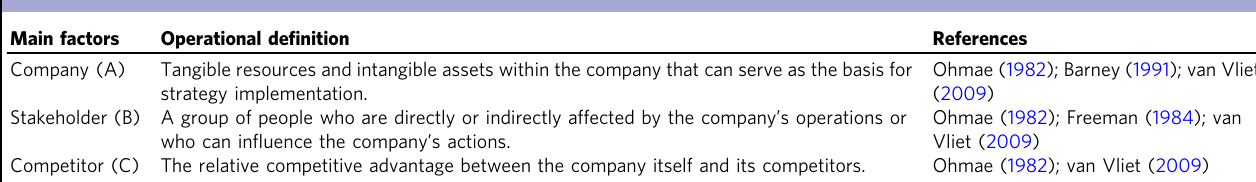
Table 2 De fi nition of